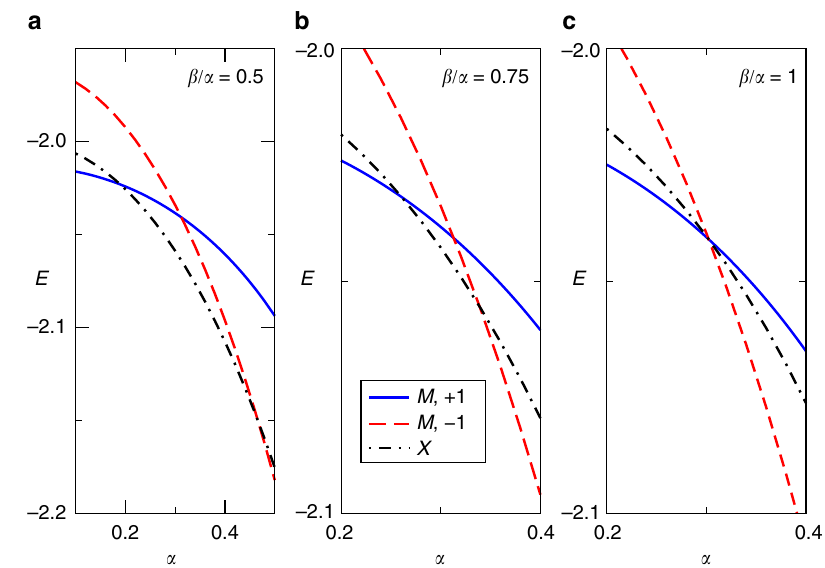
Fig. 3 Polaron energy at high symmetry points (color online). Polaron energy at X (black, dot-dash) and at M , for even (blue, full) and odd (red, dashed) bands, as a function of α . a β / α = 0.5. b β / α = 0.75. c β / α = 1. In all cases t sp = − 1, t pp = − 0.49, ϵ s = ϵ p = 0, Ω =